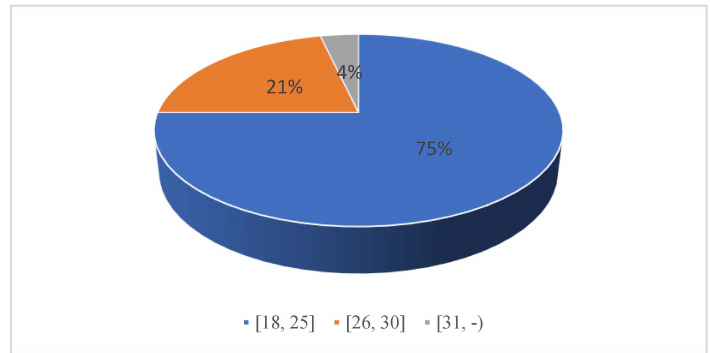
Figure 7. Ages of